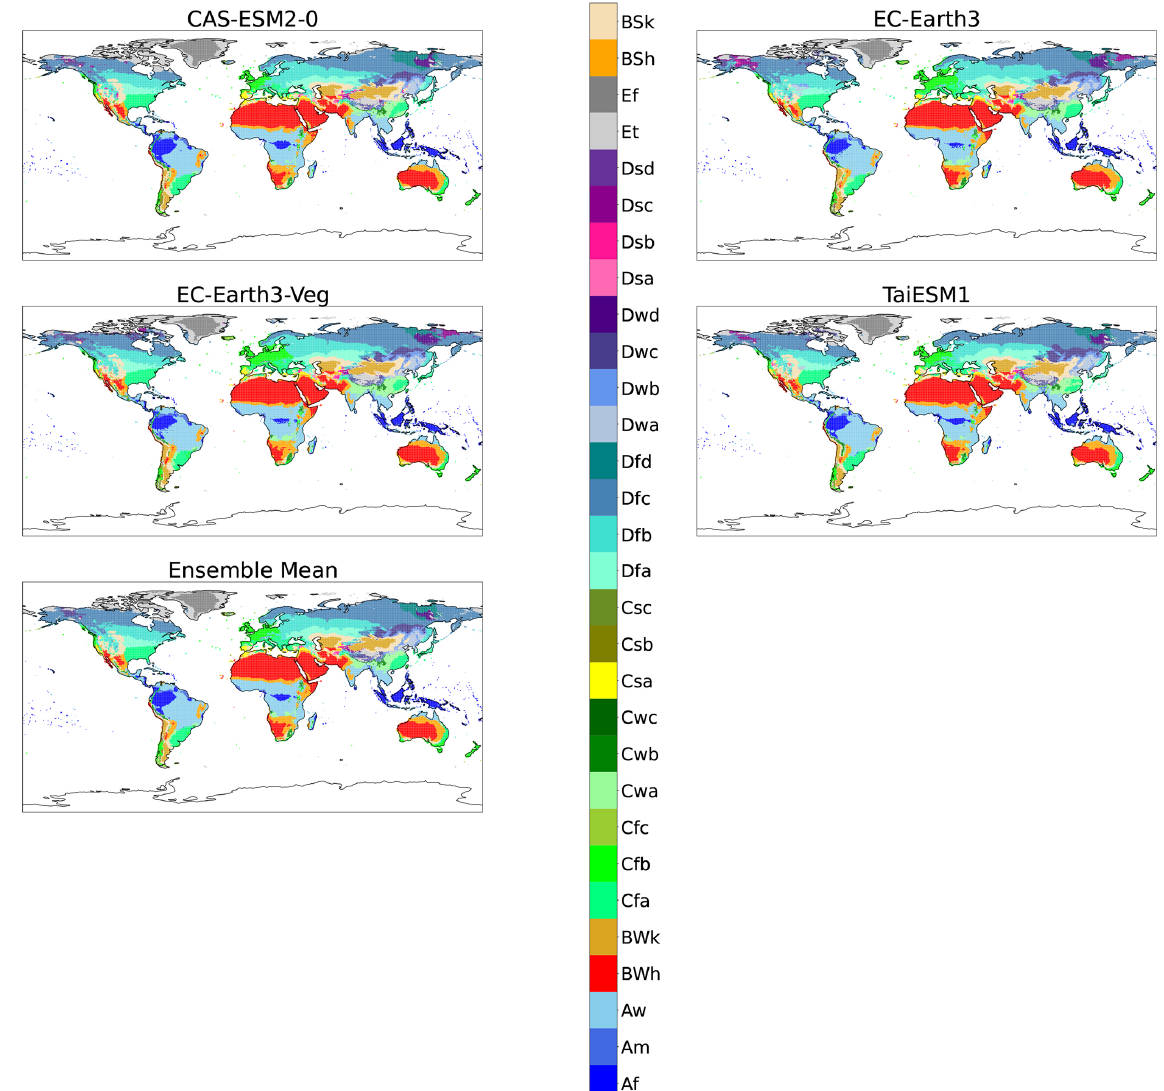
Figure A3. Maps of KG classifications for each model at + 1 . 5K with anomaly